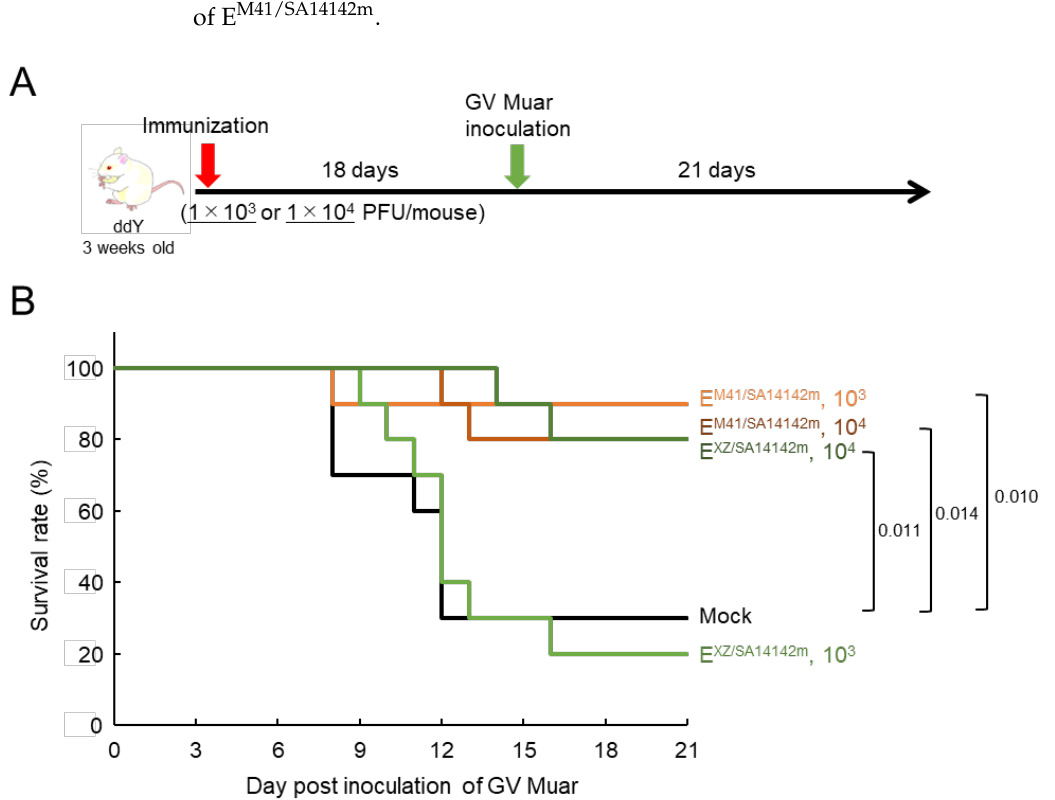
Figure 7. Protective ability of low-titer recombinant JEV strains against GV Muar strain in mice. ( A ) Experimental timeline. Mice were inoculated i.p. with 1 × 10 3 PFU or 1 × 10 4 PFU of E M41/SA14142m ( n = 10) or E XZ/SA14142m ( n = 10), or mock-inoculated ( n = 10). At 18 days after immunization, mice were inoculated i.p. with 1 × 10 4 PFU of Muar strain and observed for 21 days. ( B ) Survival curve of immunized mice after challenge with GV Muar strain. Significant p values by log-rank test are also indicated.